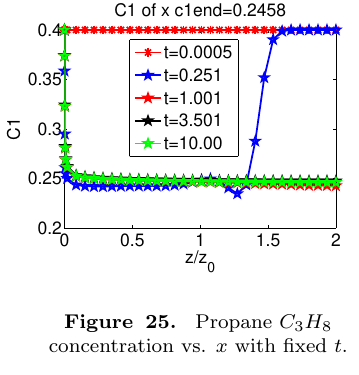
Figure 25. Propane C 3 H 8 concentration vs. x with fixed t .